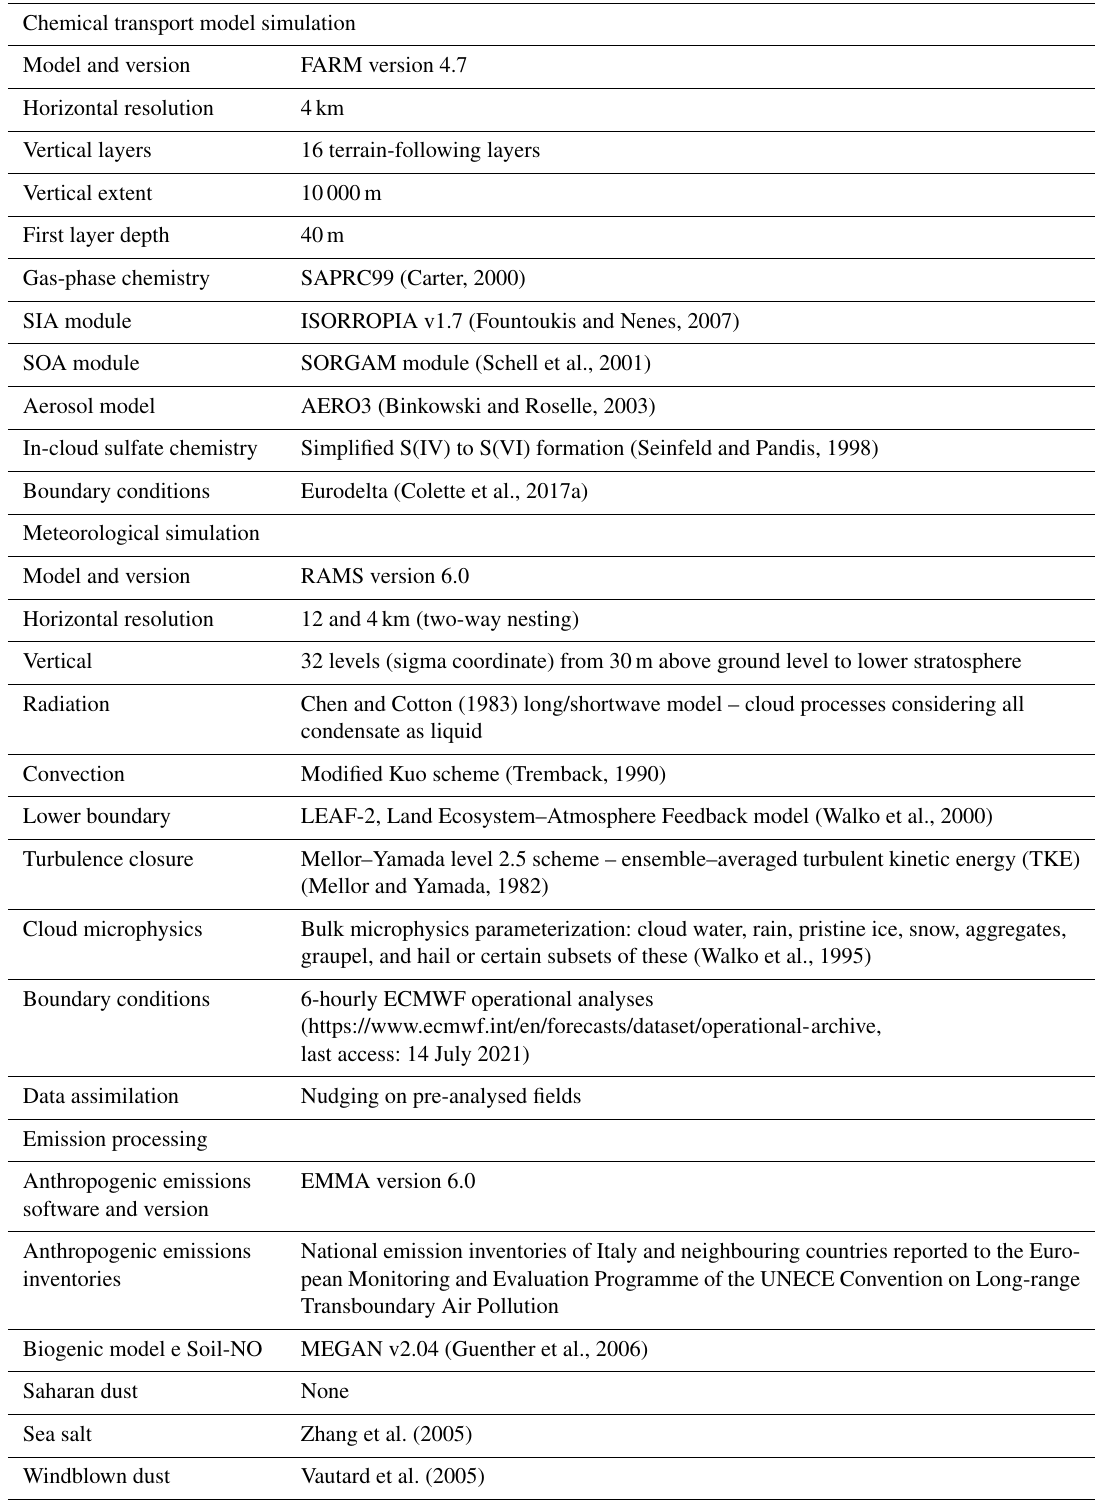
Table 1. Main features of the AMS-MINNI simulation